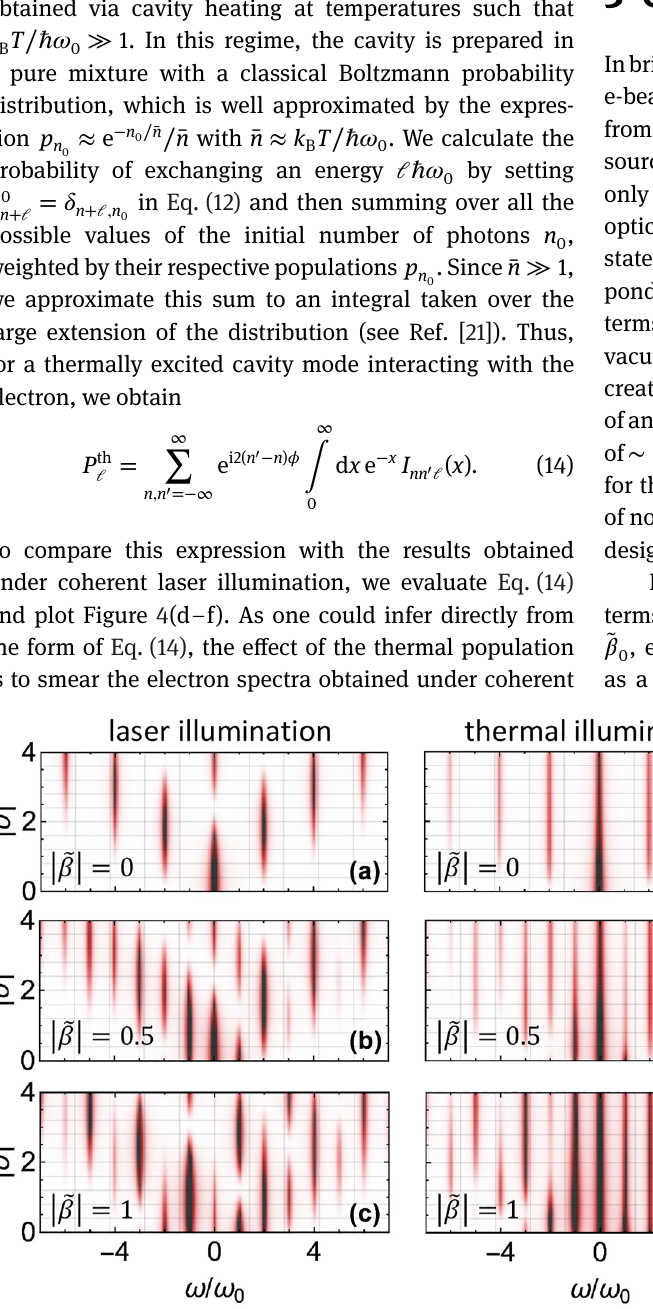
and the ponderomotive 0